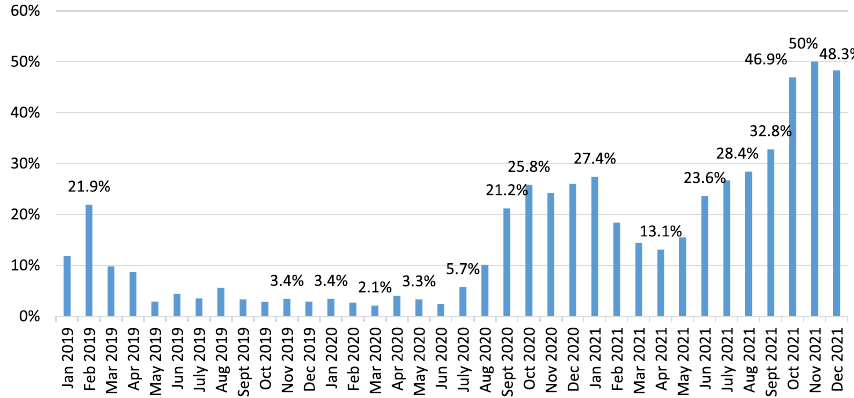
Fig. 1 Share of containers at San Pedro Bay terminals for more than five days. Source: PMSA